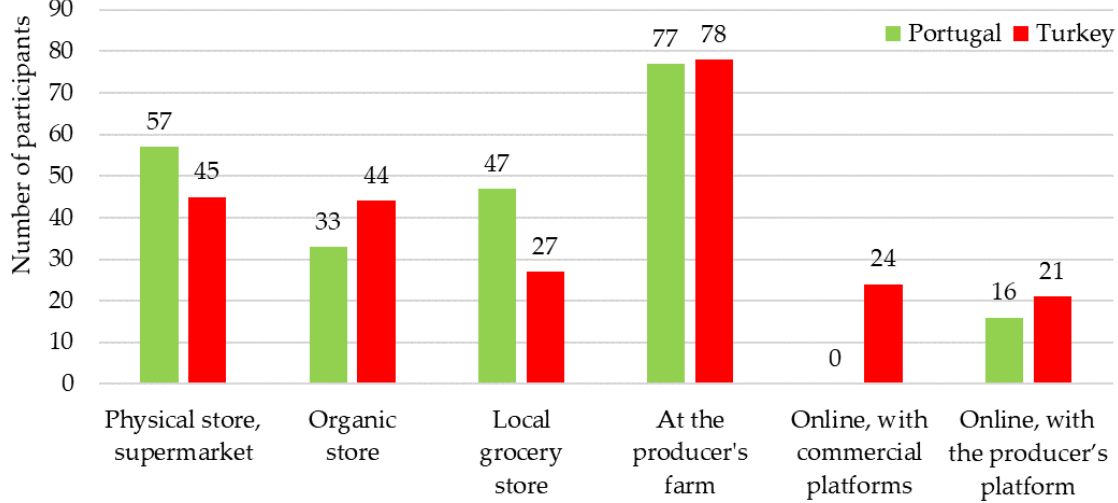
Figure 3. Places where participants purchase organic foods.